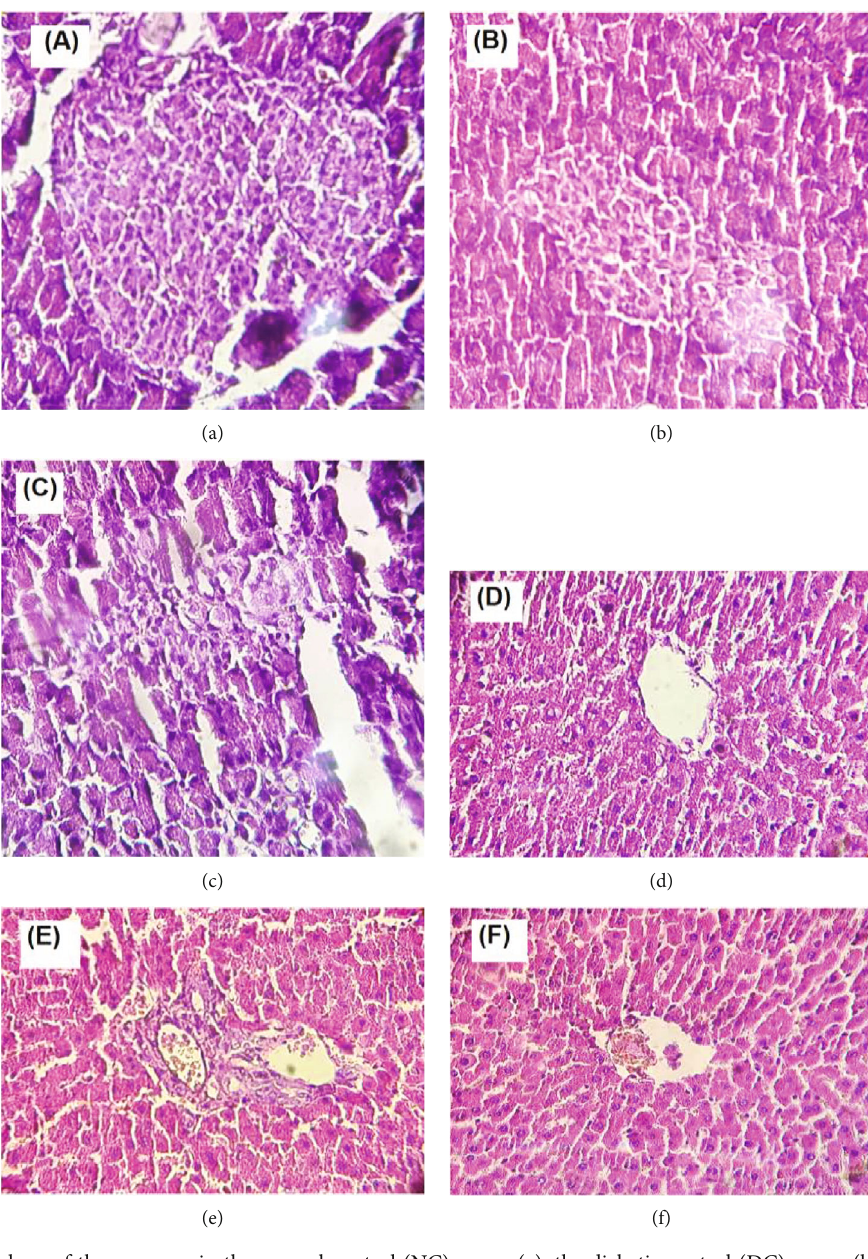
Figure 6: Histopathology of the pancreas in the normal control (NC) group (a), the diabetic control (DC) group (b), and the vaccinated STZ-injected (VS) group (c) at 400x magni fi cation. Histopathology of the liver in the normal control (NC) group (d), the diabetic control (DC) group (e), and the vaccinated STZ-injected (VS) group (f) at 400x magni fi